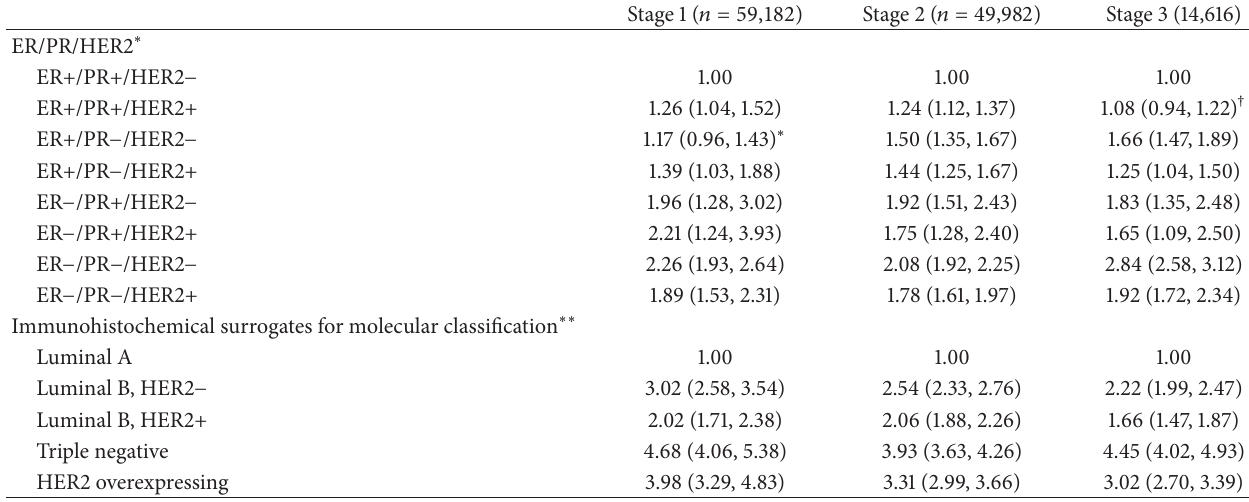
Table 3: Hazard ratios and 95% confidence intervals derived from Cox regression for ER/PR/HER2 subtype and surrogate